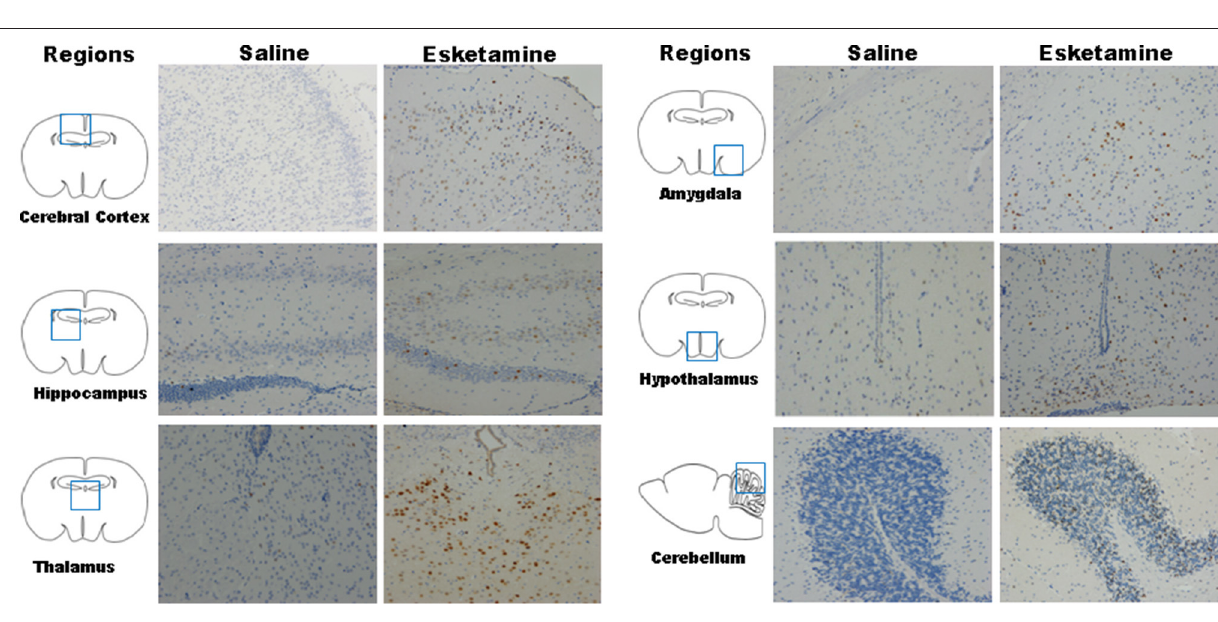
duration of loss of RR and PWR to get an anesthesia state which were not reached by either esketamine or midazolam